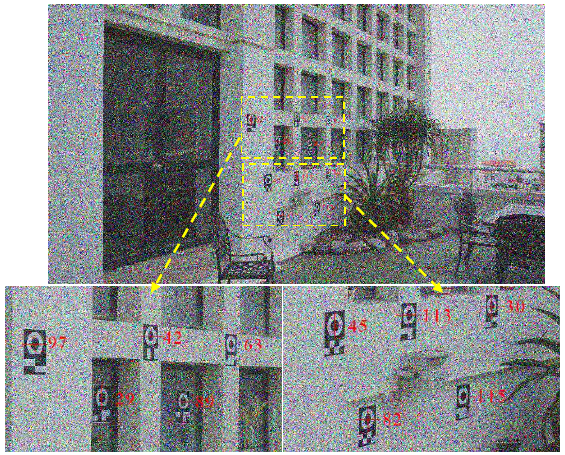
Figure 7. Identification and location of the coded targets under Gaussian noise environment (viewpoint: 60° and 100  